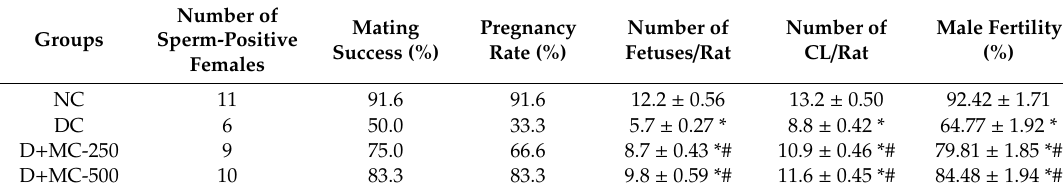
Table 7. E ff ect of MC on mating success and male fertility % of STZ-induced diabetic male rats. CL, corpora